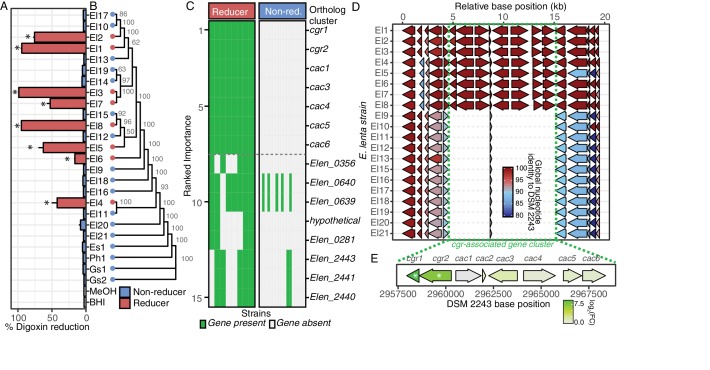
Comparative genomics expands the boundaries of the cgr operon.(A) Survey of digoxin reduction in 21 strains of E. lenta (El#), 2 strains of Gordonibacter spp. (Gs#), E. sinensis (Es1), and Paraeggerthella hongkongesis (Ph1) (Figure 1—source data 1 and 2) revealed eight strains capable of reducing digoxin to dihydrodigoxin (*p<0.05, ANOVA with Dunnett’s test vs. vehicle controls). Data represents mean ± standard error of the mean (SEM) over three biological replicates. (B) Digoxin reduction did not correlate with phylogeny in E. lenta species (cladogram displayed with bootstrap values indicated at nodes; p=0.275, K = 0.049, Blomberg’s K). (C) Comparative genomics using a random forest classifier (see Materials and methods) revealed seven genes with perfect predictive accuracy for digoxin reduction. The orthologous cluster identified as hypothetical corresponds to an open reading frame present at position 299442..2995131 in the DSM 2243 reference genome. (D) Analysis of genomic context revealed a highly conserved 10.4 kb locus of 7 genes that flank a short, conserved hypothetical gene, herein termed the cgr-associated gene cluster (cac). (E) Analysis of gene expression in the cgr-associated gene cluster revealed only the cgr-locus was significantly upregulated by exposure to digoxin. * FDR < 0.1 (Figure 1—source data 3).10.7554/eLife.33953.004Figure 1—source data 1.Bacterial strains used in study.Acronyms: ND (Not Detected), NA (Not Available), BHI (Brain Heart Infusion), BHIA (Brain Hearth Infusion with supplemented arginine), FAA (Fastidious Anaerobe Agar), GAM (Gifu Anaerobic Medium), DDMM (Dopamine Dehydroxylation Minimal Medium), Nag (Nutrient Agar).10.7554/eLife.33953.005Figure 1—source data 2.Digoxin Reduction by E.lenta and related bacterial isolates.10.7554/eLife.33953.006Figure 1—source data 3.Differential gene expression analysis of cgr-associated genes in E.lenta DSM 2243.